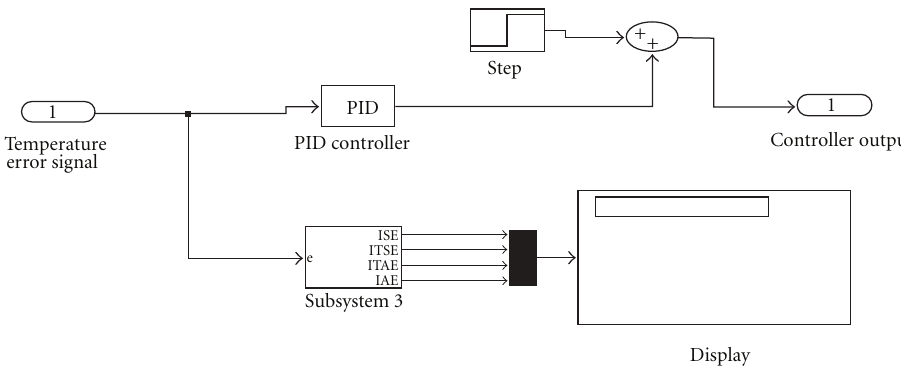
Figure 3: Simulink model of PID controller.